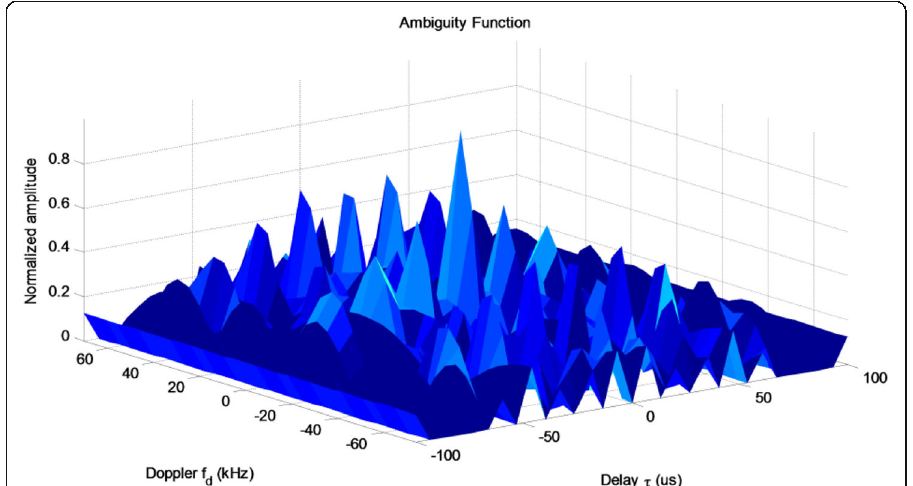
Fig. 4 Ambiguity function of 16-bit PTM